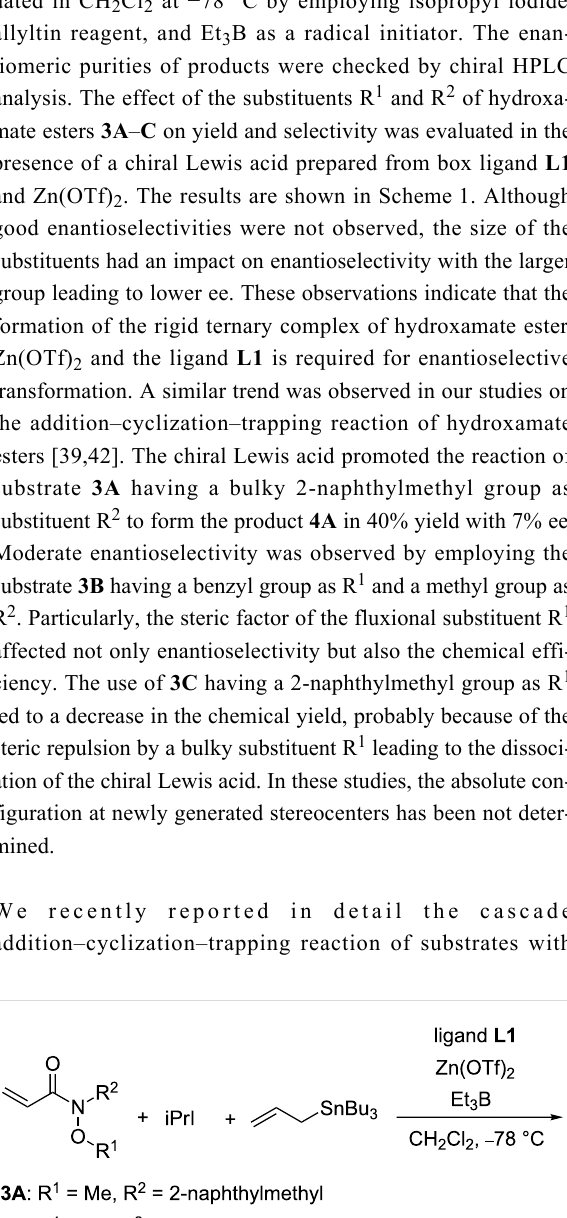
Figure 1: Cascade bond formation based on radical reactions.